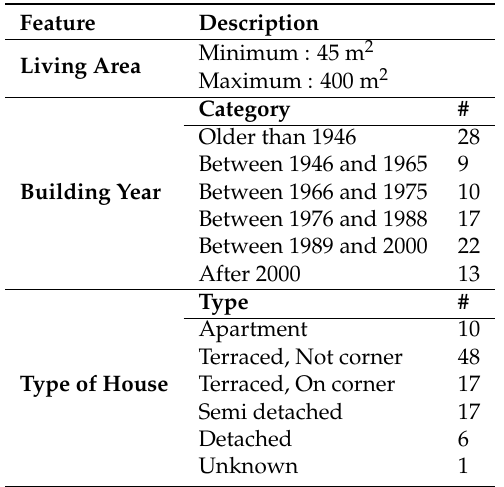
Table 1. General information of the houses in the dataset.